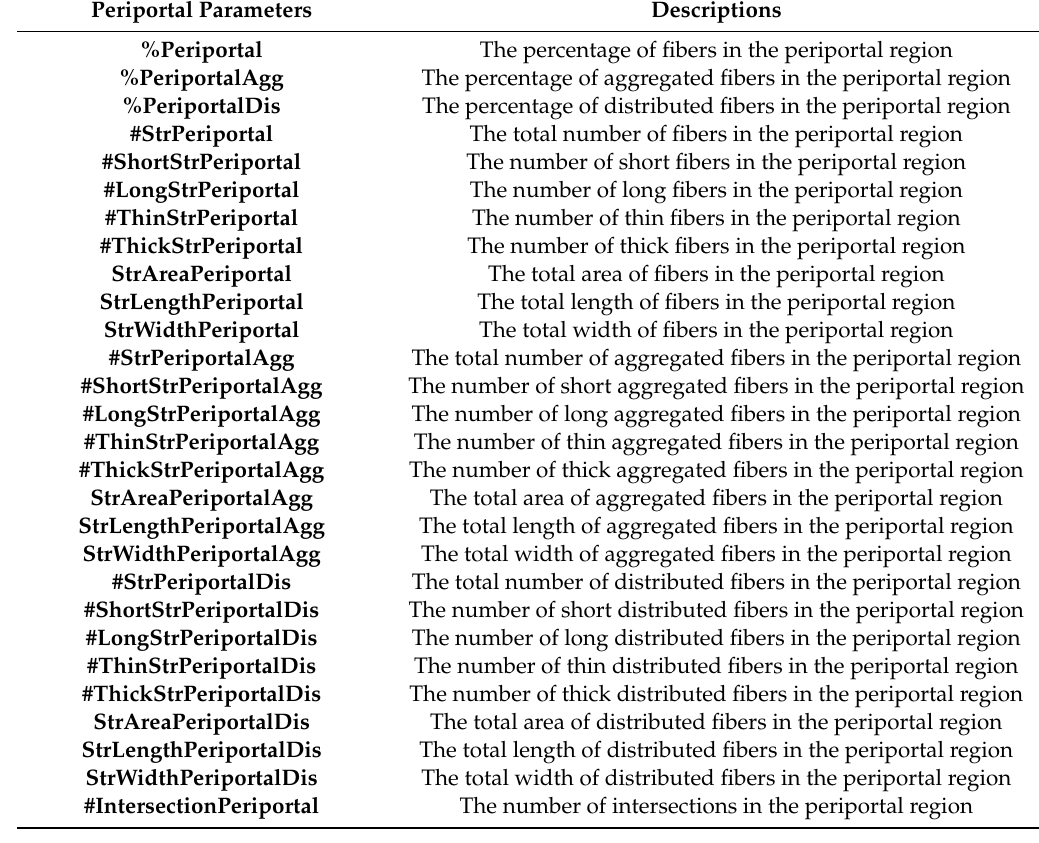
Table 2. List of newly created periportal parameters.